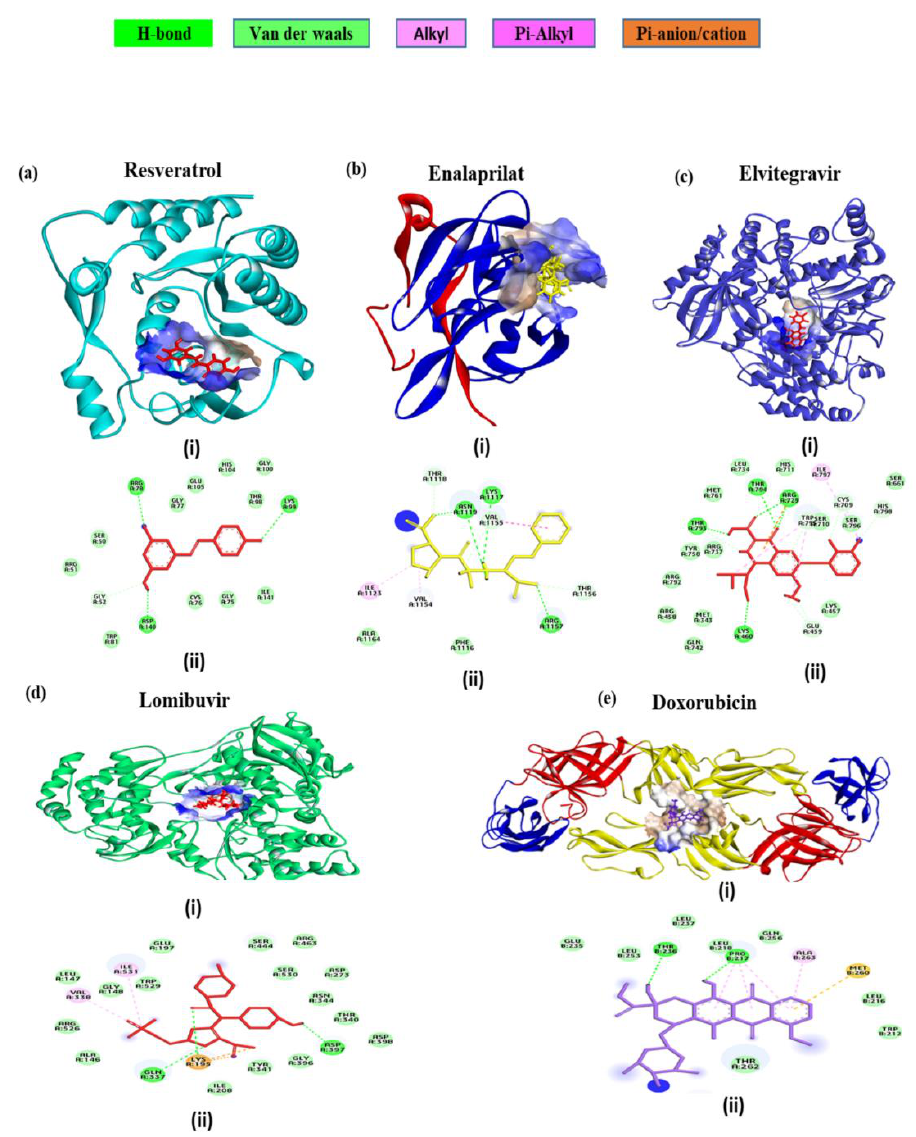
Figure 8. Molecular docking interaction of five repurposed drugs with DENV structural and non- structural proteins. Ribbon diagram with the solvent surface rendered view (probe radius 1.4 Å) and 2-dimensional interaction diagram showing interaction with DENV: ( a ) NS5 methyltransferase domain, ( b ) NS2B-NS3 protease domain, ( c ) NS5 RdRp domain, ( d ) NS5 RdRp domain, and ( e ) Envelope glycoprotein complex. (i)—3D interaction diagram, (ii)—2D interaction